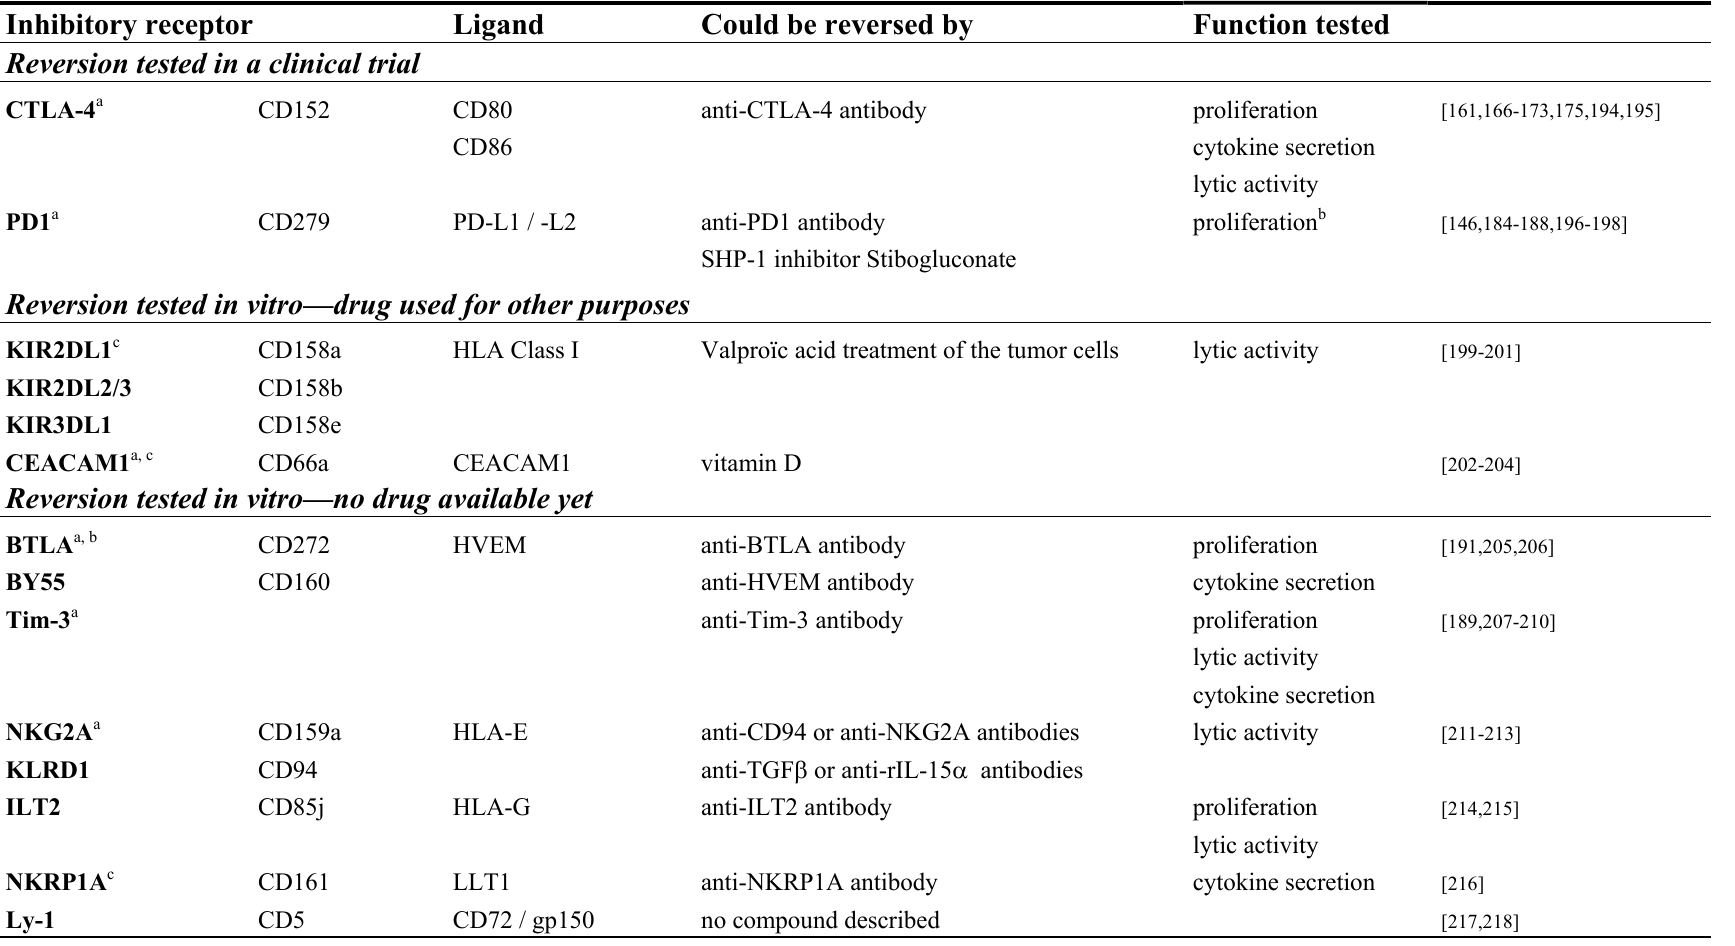
Table 3. Surface inhibitory receptors expressed by TIL and counteracting